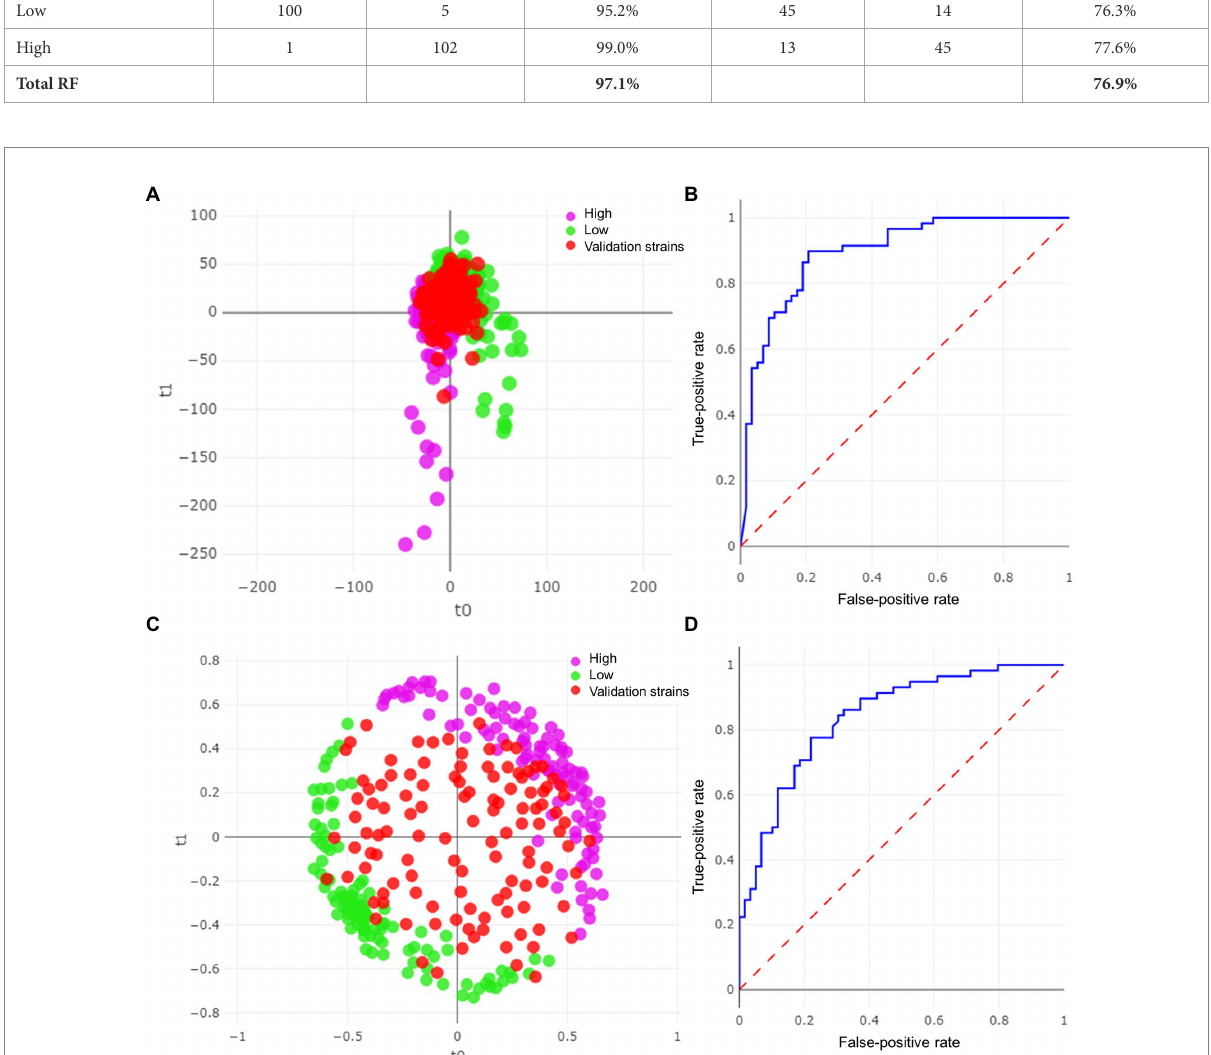
FIGURE 1 Results of the models for Staphylococcus aureus strains. (A) Partial least squares-discriminant analysis (PLS-DA) plot with validation strains. (B) ROC curve for PLS-DA model. (C) Random forest (RF) model with validation strains. (D) ROC curve for RF